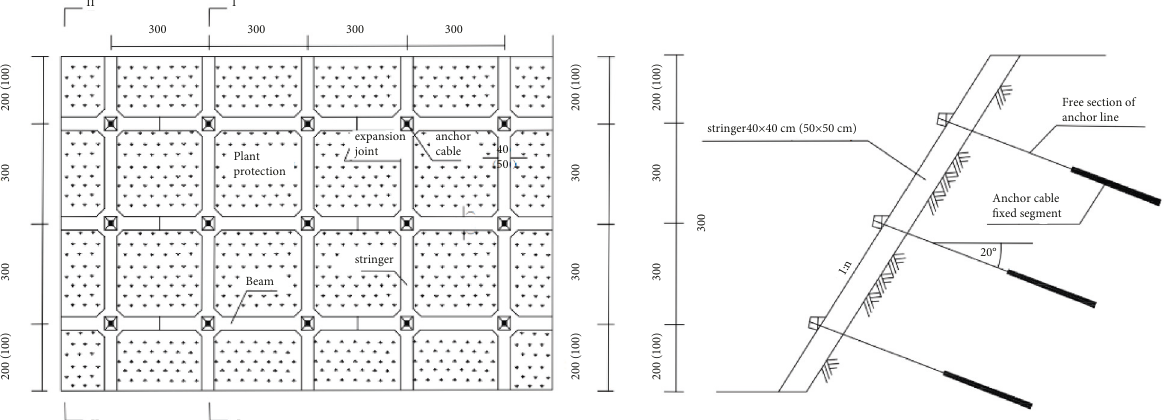
Figure 12: Construction of anchor cable